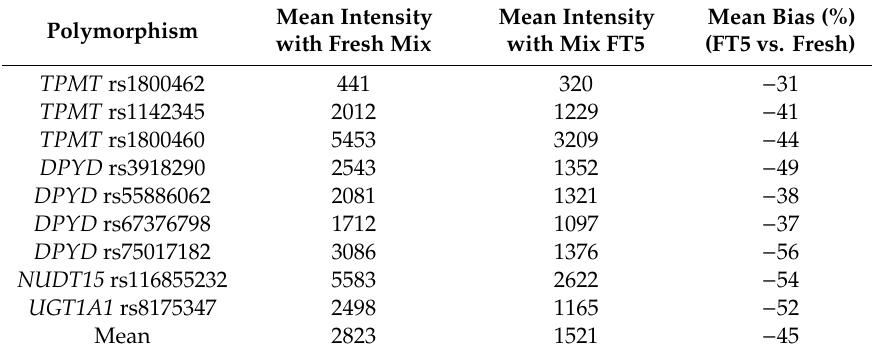
Table 4. Stability of the pool of primers and probes ready for